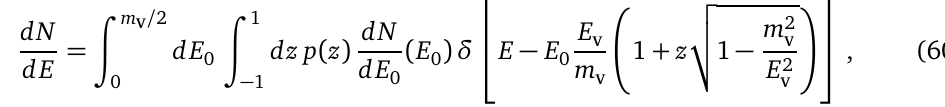
= 1 at T = 10 4 TeV, m i